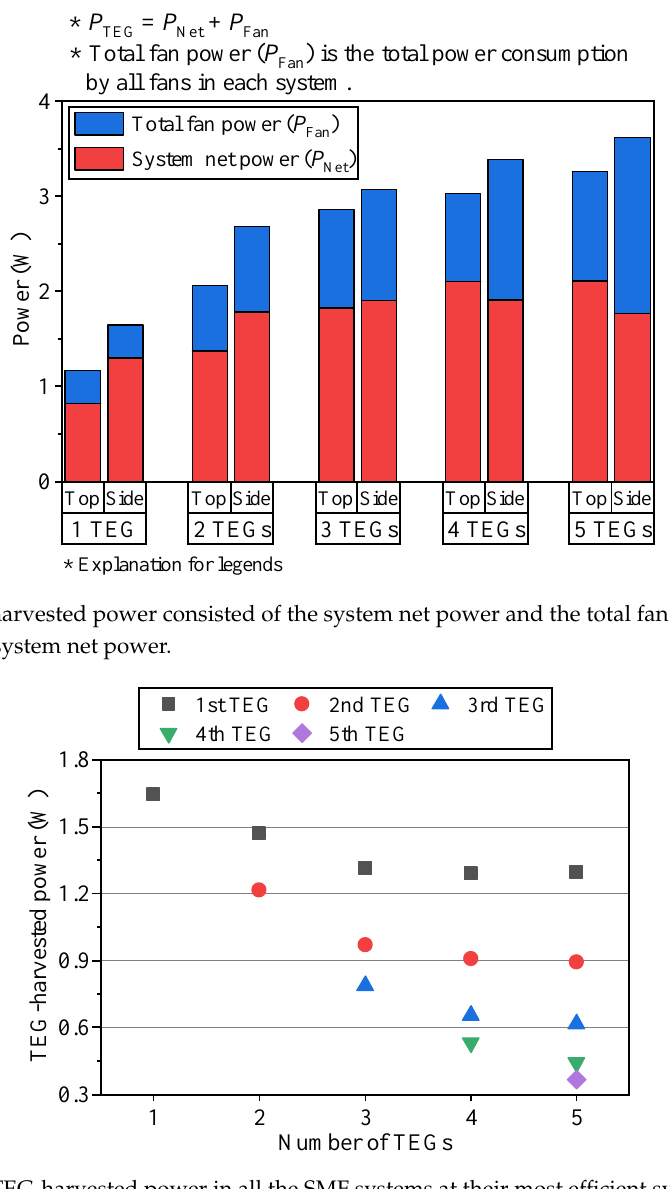
Figure 15. Each TEG-harvested power in all the SMF systems at their most efficient system net power. Table 3 summarizes the most effective fan speed, the system net power, and the average net power per unit TEG for each system configuration. The most effective fan speed of the TMF system does not change as the number of TEG increases while the most effective fan speed of the SMF system increases as the number of TEG increases. The increase in the fan power consumption due to the higher fan speed and the limited heat exchange capacity are the main reasons for lower net power per unit TEG with a higher number of TEGs. However, the SMF system generates up to 58.6% more average net power per unit TEG compared to the TMF system with the same number of TEGs. We find that the SMF system generates the most efficient P Net at 13,000 RPM with four